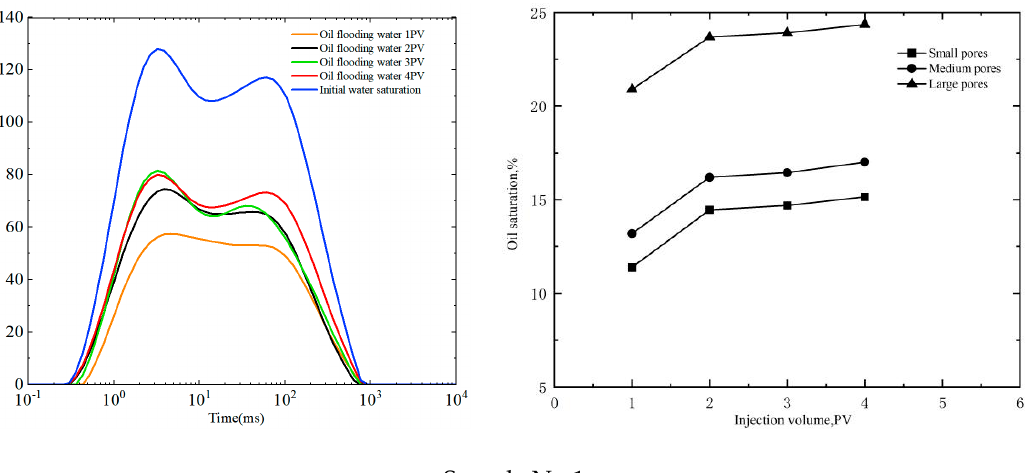
Figure 7. T 2 spectrum distribution of representative cores (No. 1) of Type II in the charging process and changes in oil saturation in different pores.